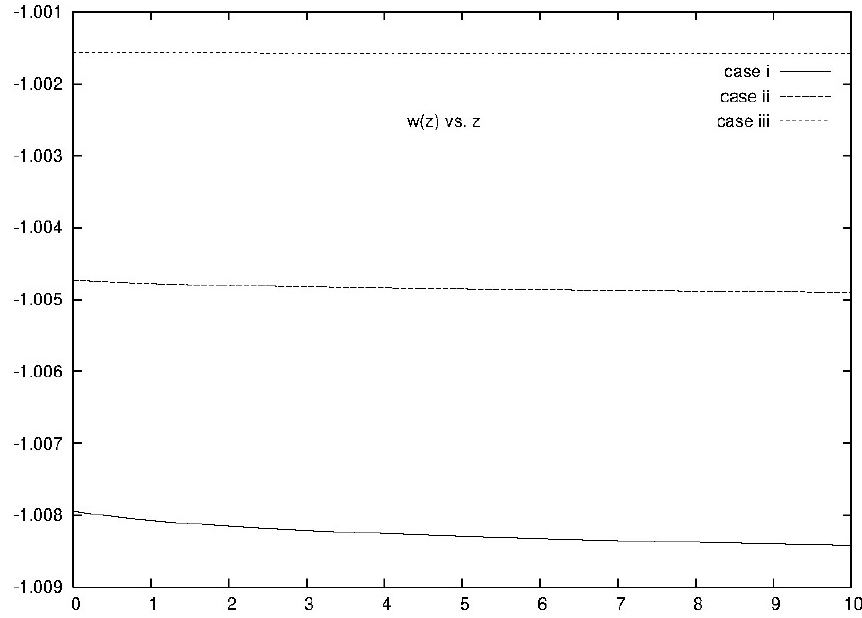
Figure 1. The equation of state w(z) vs. the redshift z for the three cases explicitly calculated in this paper: (i) [full line] No neutrino contribution to the dark energy and the scalar mass M = 3.96